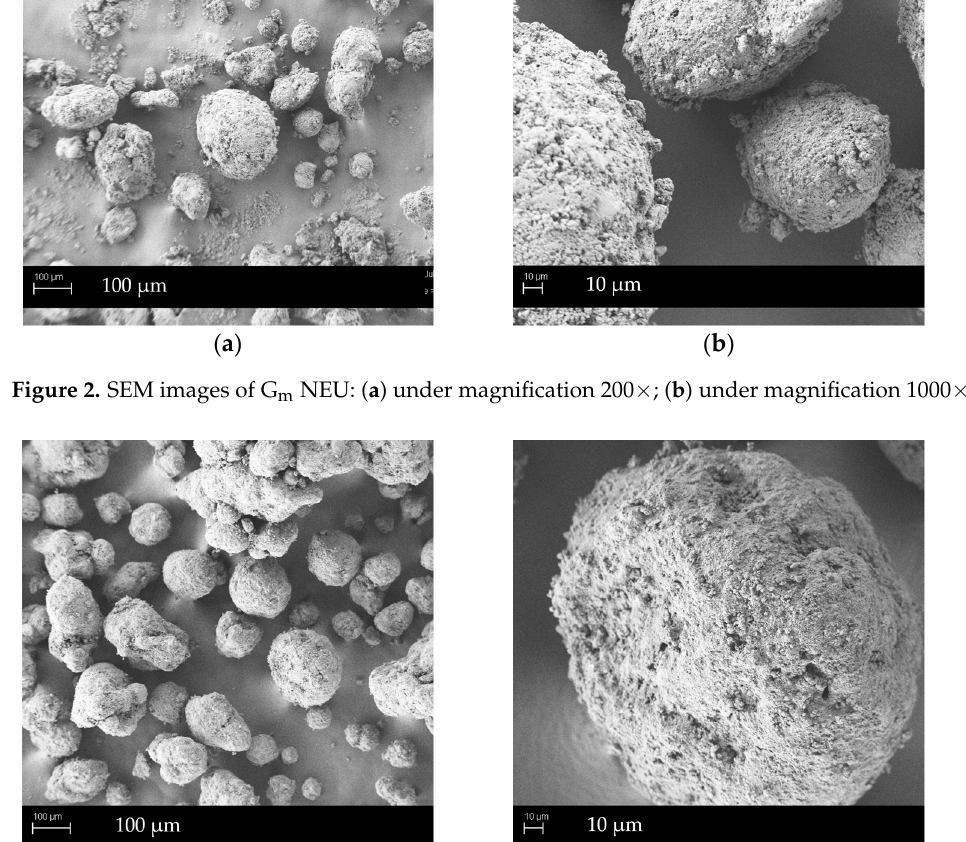
× ; ( b ) under magnification 1000 ×